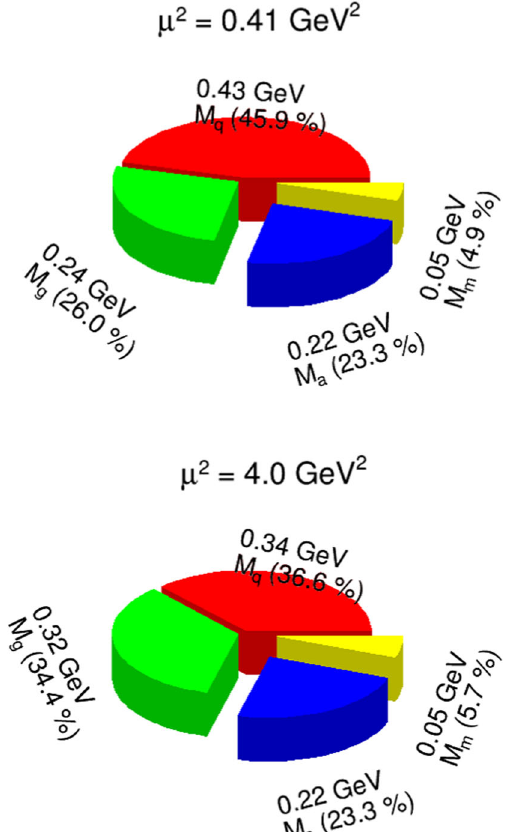
Fig. 4 Decompositions of the proton mass at μ 2 = 0 . 41 GeV 2 and μ 2 = 4 GeV 2 , with b = 0 . 07